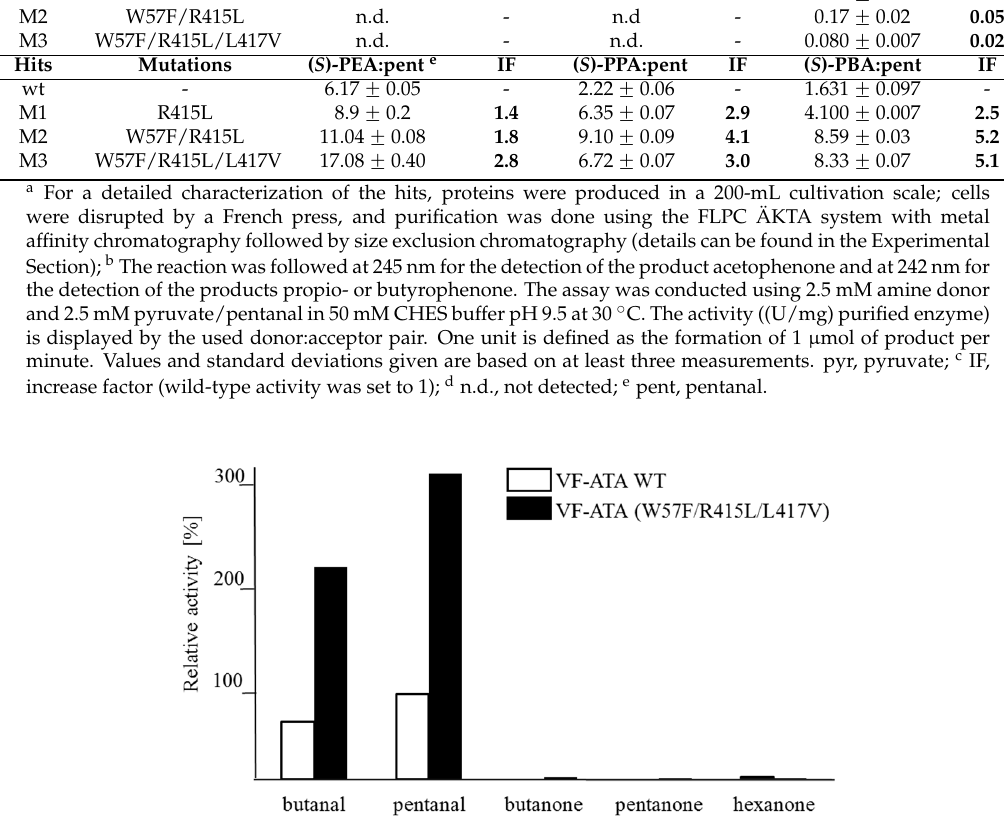
Figure 3. Activity determination using different amine acceptors and ( S )-PEA as the donor. The wild-type VF-ATA (VF-ATA wt) and the variant M3 (W57F/R415L/L417V)) were verified for the conversion of C4/C5-aldehydes and C4–C6-ketones at pH 9.5. The relative activity was set to 100% pentanal:( S )-PEA based on wild-type VF-ATA.